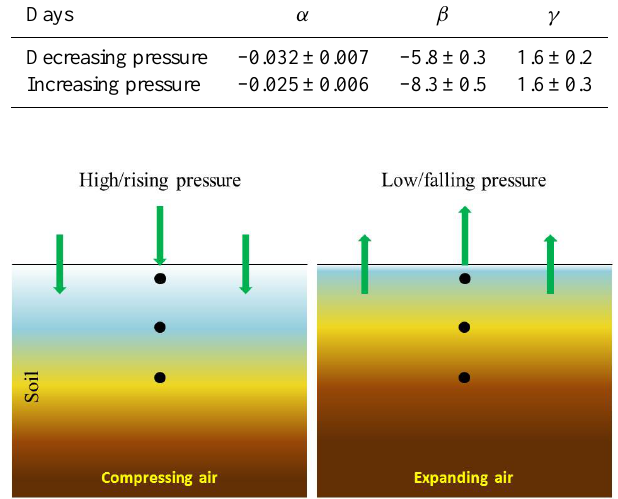
Fig. 6. Schematic of CO transport in soil air layers (a) compress- ing under high / rising synoptic pressure, and (b) expanding under low/falling pressure. High CO 2 molar fractions 2 are denoted in brown and low values in